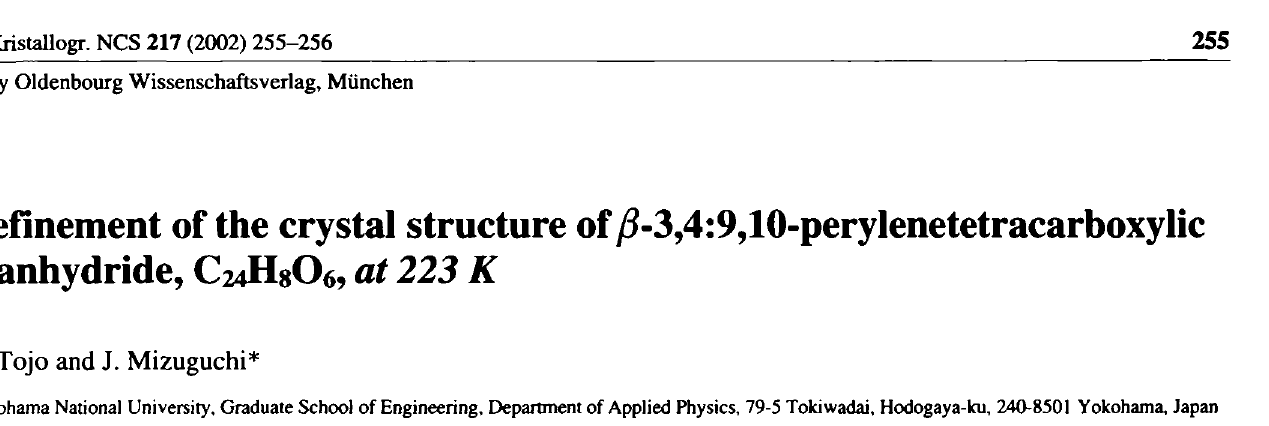
Table 1. Data collection and handling.